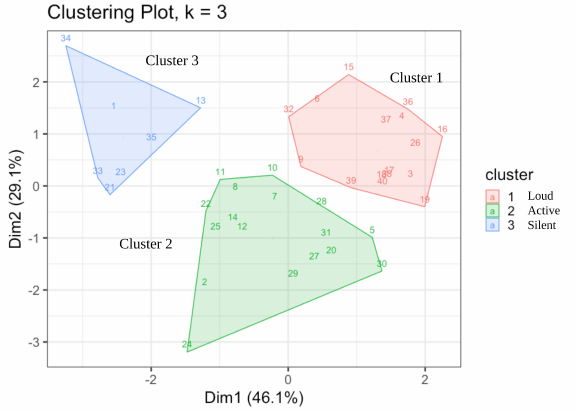
Figure 3: Clustering of noise stimuli in two primary dimensions using k-means clustering method.